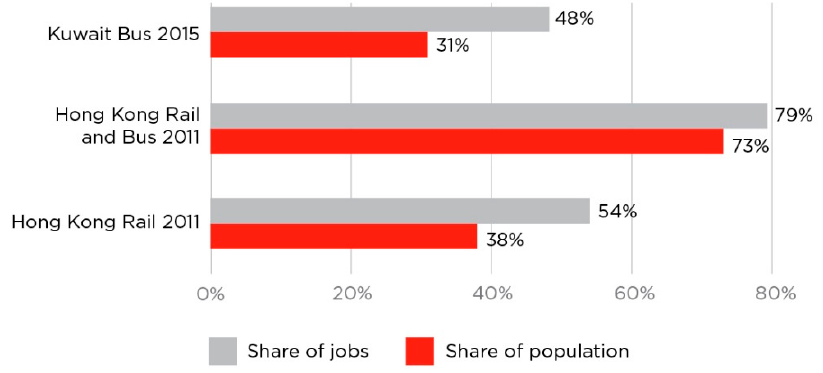
Figure 9. Residential and workplace accessibility to public transport.